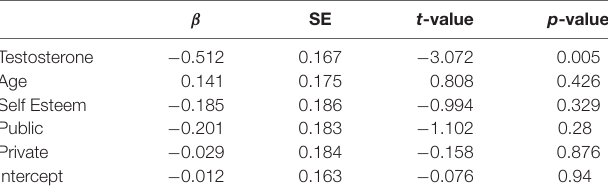
TABLE 2 | Summary of the statistical values of the multiple regression analysis. β SE t